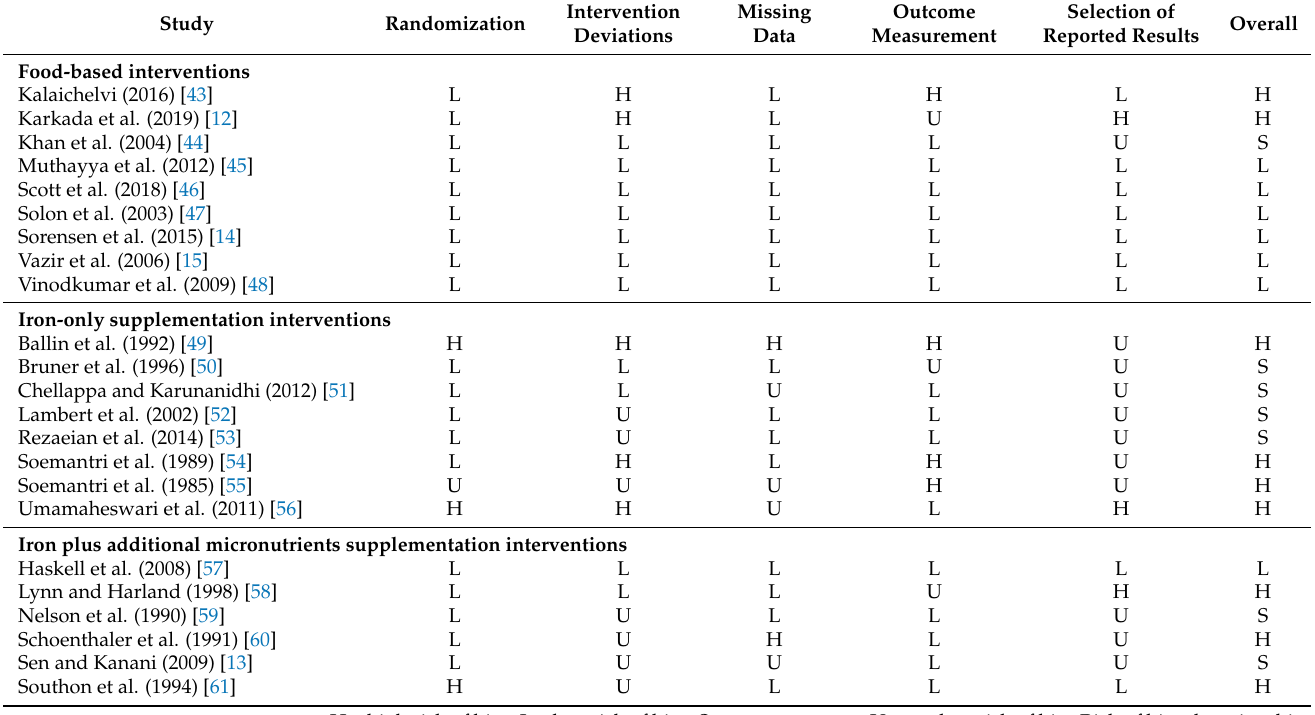
Table 3. Risk of bias summary for randomized iron-containing intervention studies assessing aca- demic outcomes or dimensions of learning.